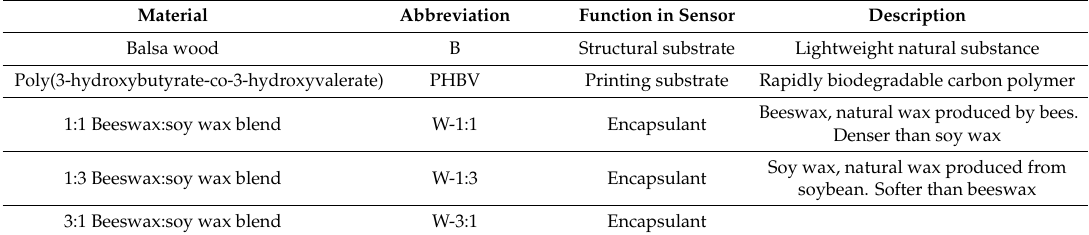
Table 1. Description of candidate sensor materials used in the